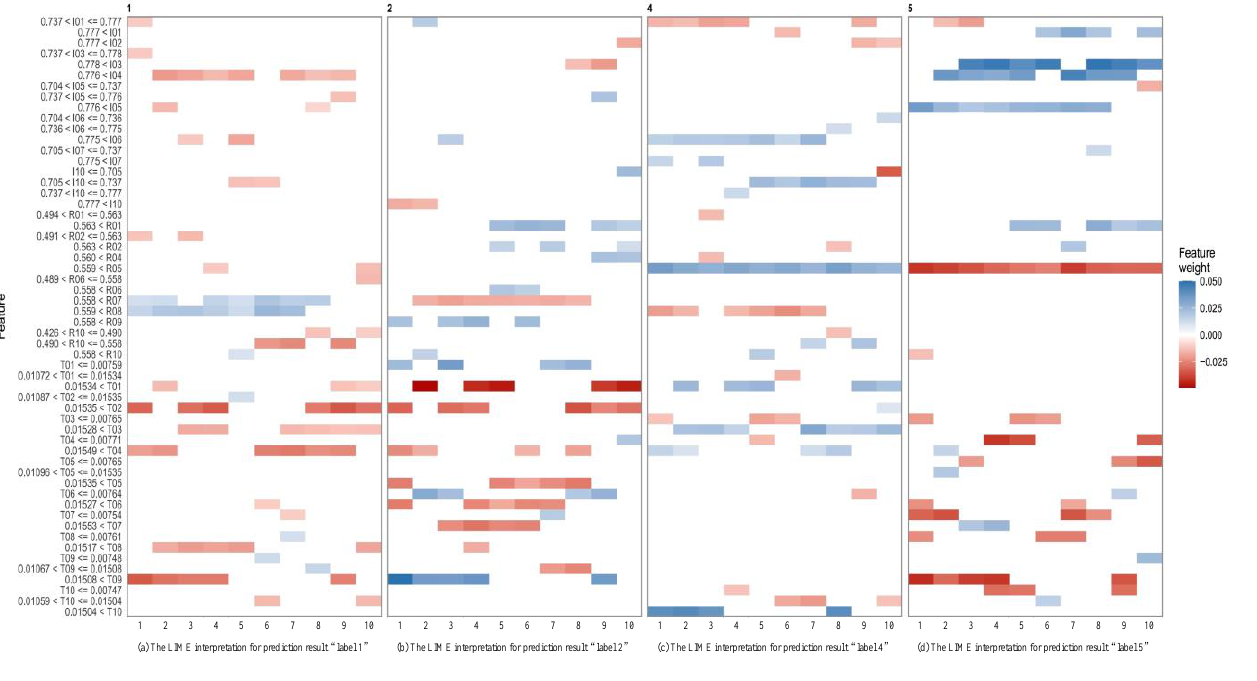
Figure 6. The LIME explanation results for the prediction cases 1 – 10. The sub-figures ( a – d ) are the explanation results for labels 1/2/3/4. explanation results for labels